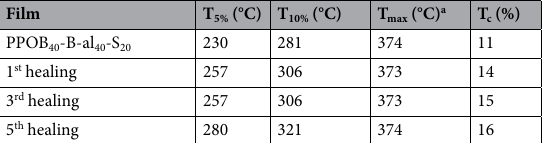
Table 3. Thermal properties of the PPOB 40 -B-al 40 -S 20 films after each healing cycle. a These values extracted from derivative of TGA (Fig. S6) presented in supporting information. T 5% : The temperature for which the weight loss is 5%. T 10% : The temperature for which the weight loss is 10%. T max : The temperature for maximum weight loss. T c : The char yield at 800